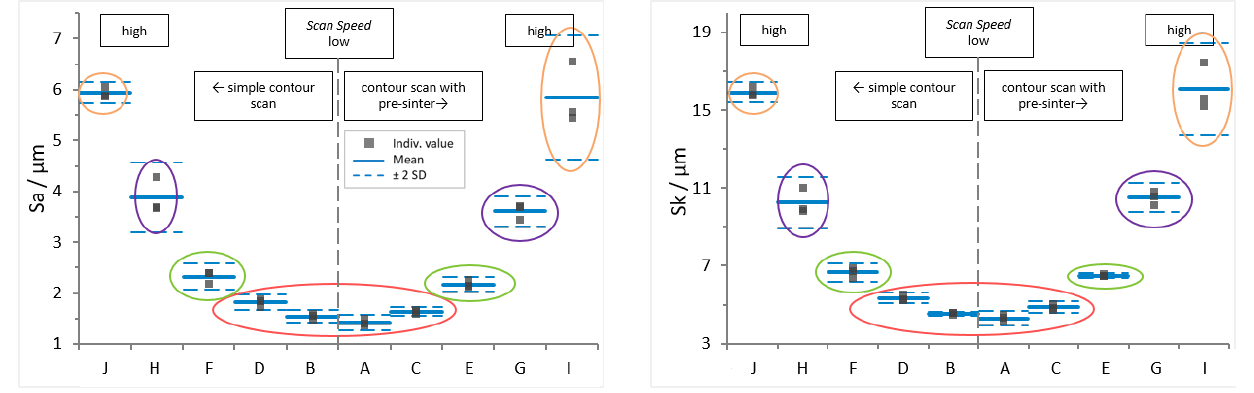
Figure 5. Sa and Sk for samples with different contour scan. L-filter 0.25 mm, S-filter 20 µm. Mean ± 2SD.